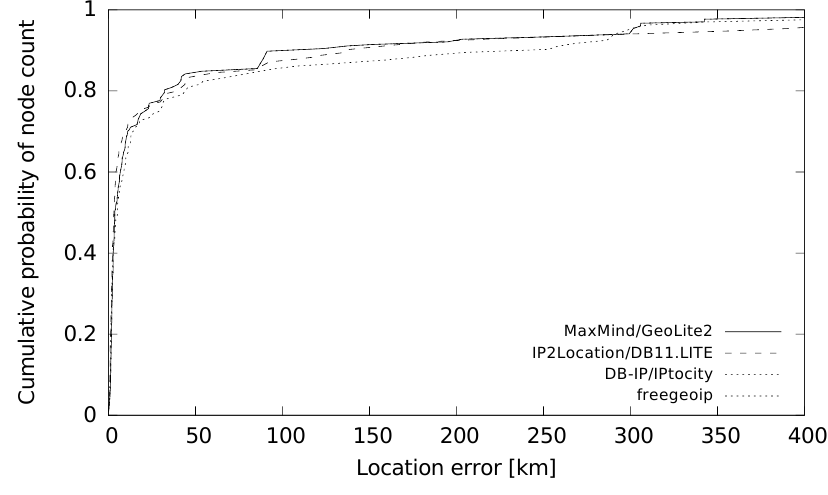
Figure 7. Location accuracy for ground truth dataset with major cities.